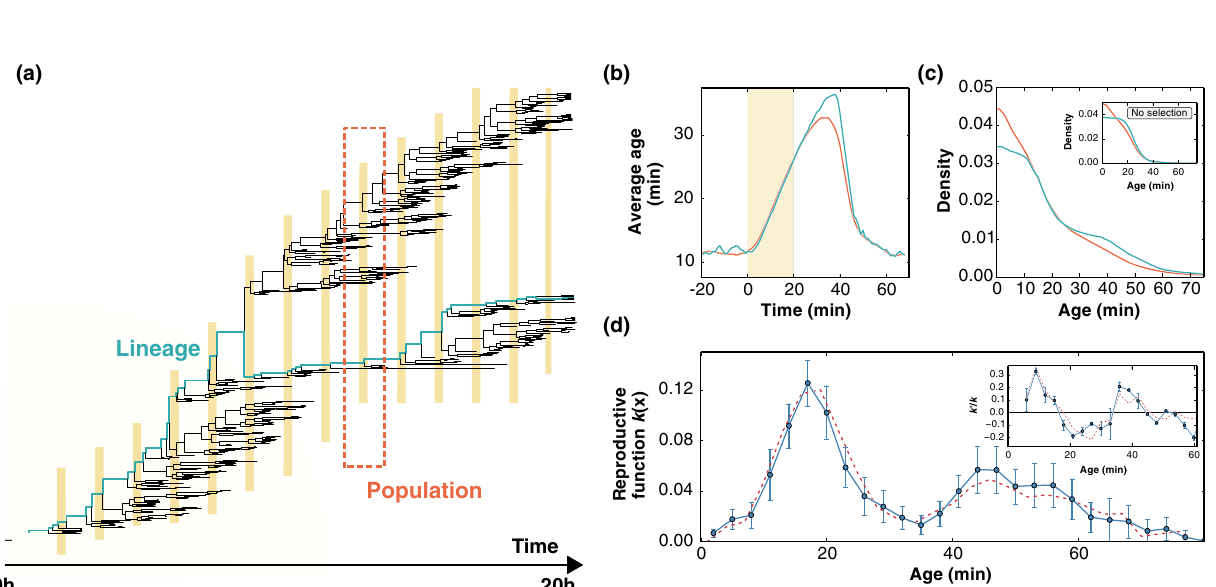
FIG. 4. Lineage distribution and selection. (a) Bacterial pedigree of a population for t ¼ ½ 0 ; 20 (cid:3) h. The difference between lineage (teal) and population (orange) measurements is highlighted. The yellow bars denote antibiotic treatments. (b) Comparison between the average age of the population and surviving lineages during each treatment cycle. (c) The age distribution of population is underrepresented for ages between 25 and 50 min and enriched with younger cells. The different distributions reflect the age-dependent rate of lysis, whose effect is to remove older cells from the population but not from the surviving lineage. Inset: Lineage and population age distributions for cell populations grown in the absence of selection (i.e., constant conditions). (d) Comparison between the two measurements of the reproduction function, obtained using direct life-history measurements [ k ð x Þ ¼ b ð x Þ l ð x Þ , dashed line] or extracted from the surviving lineage age distribution [ k s ð x Þ in Eq. (4), blue circles], is in very good agreement. Data are reported as the population average (cid:4) s : d : ( n ¼ 18 populations). Inset: Comparison between the rate of change of the reproduction function [ κ ð x Þ ≡ k 0 ð x Þ =k ð x Þ ] obtained from the life history and surviving lineage measurements (mean (cid:4) s : d : , n ¼ 18